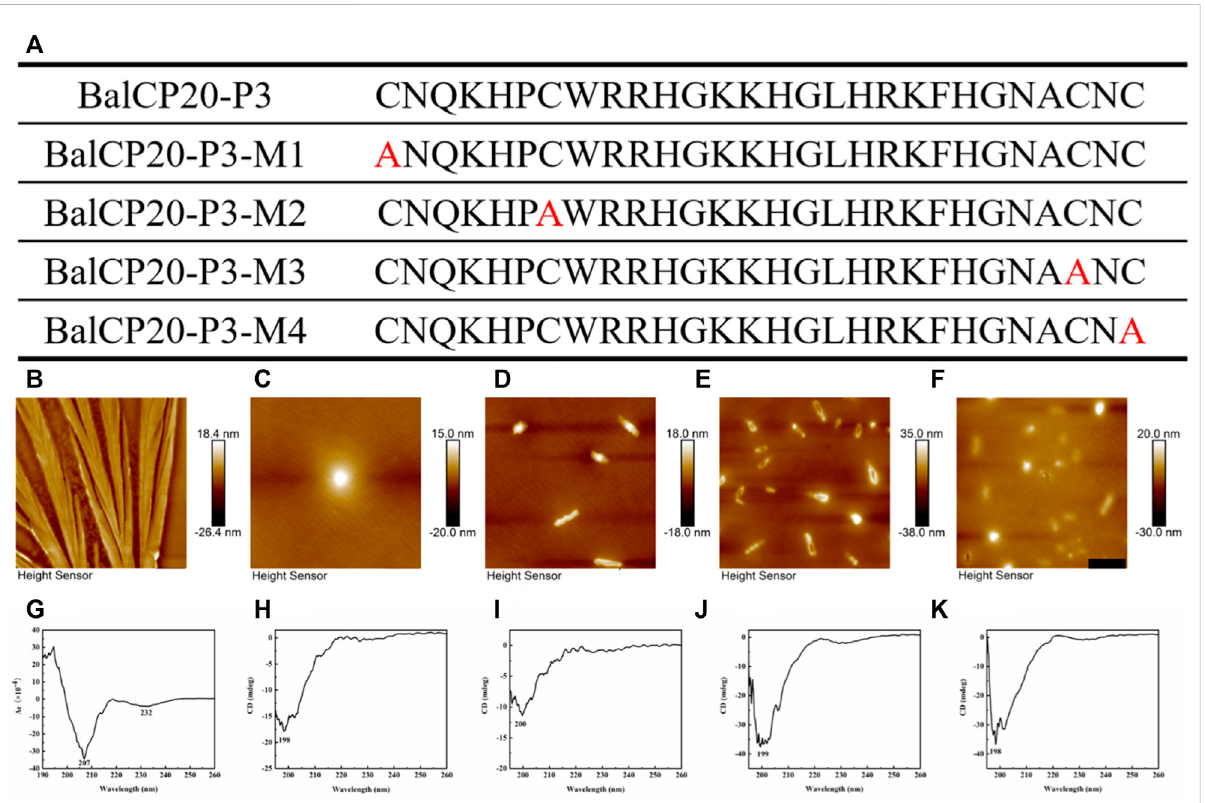
FIGURE 4 Sequence design, AFM, CD of BalCP20-P3 and its mutants. (A) BalCP20-P3 and its mutant amino acid sequence design. (B) Mutants mutated amino acid residues are marked in red, and BalCP20-P3 presents a wheat spike-like structure. (C) Spherical self-assembly of BalCP20-P3-M1. (D) BalCP20-P3-M2 and BalCP20-P3-M3 (E) are rod-like structures of varying lengths. (F) BalCP20-P3-M4 has either spherical or rod-like structures. Thescalebarsof (B – F) are1 μ m. (G) CDofBalCP20-P3. (H) CDofBalCP20-P3-M1. (I) CDofBalCP20-P3-M2. (J) CDofBalCP20-P3-M3. (K) CD of BalCP20-P3-M4. The abscissa is the wavelength (190 – 260 nm) and the ordinate is the